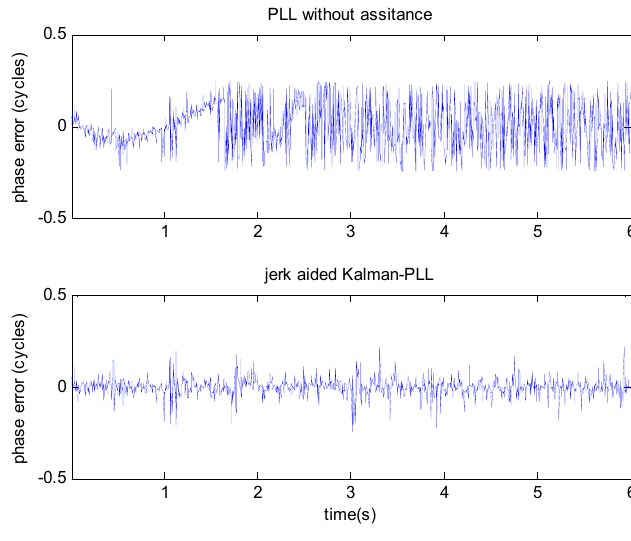
Figure 8. Phase tracking errors comparison of GNSS simulator collected